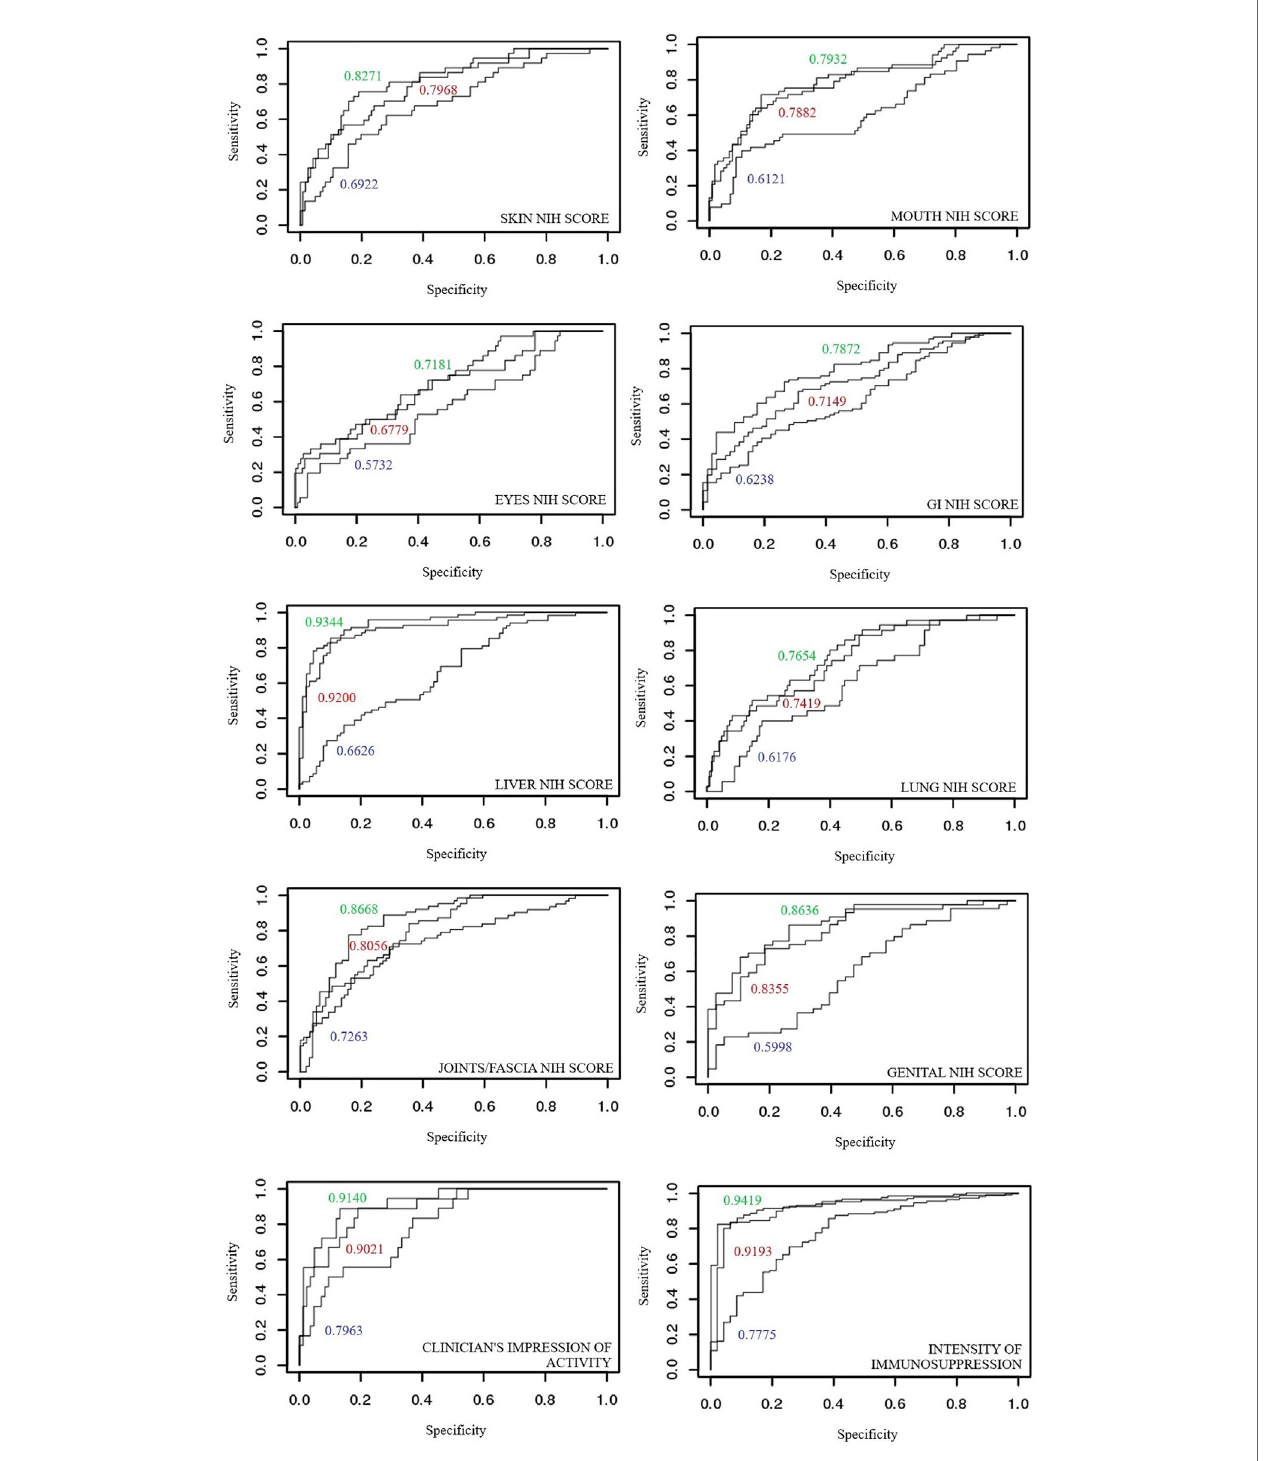
FIGURE 5 | Comparison of areas under ROC curves for discriminant models of individual organ systems with and without cGvHD: (blue) glycans measurements, (red) laboratory parameters and (green) model combining laboratory parameters and glycan measurements.